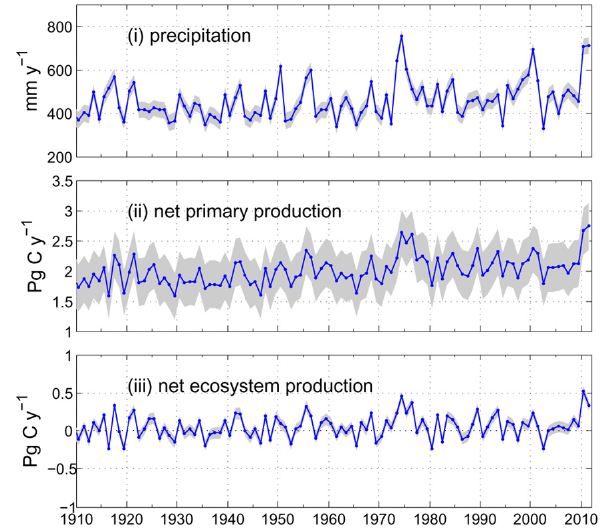
Fig. 5. Annual time series of Australian continental (i) precipita- tion; (ii) NPP; and (iii) NEP (NPP – RH in the absence of fire and harvest). Shading represents 1 σ uncertainties on the mean, and in- cludes contributions from parameter uncertainties and forcing un- certainties, as evaluated in Haverd et al. (2012).